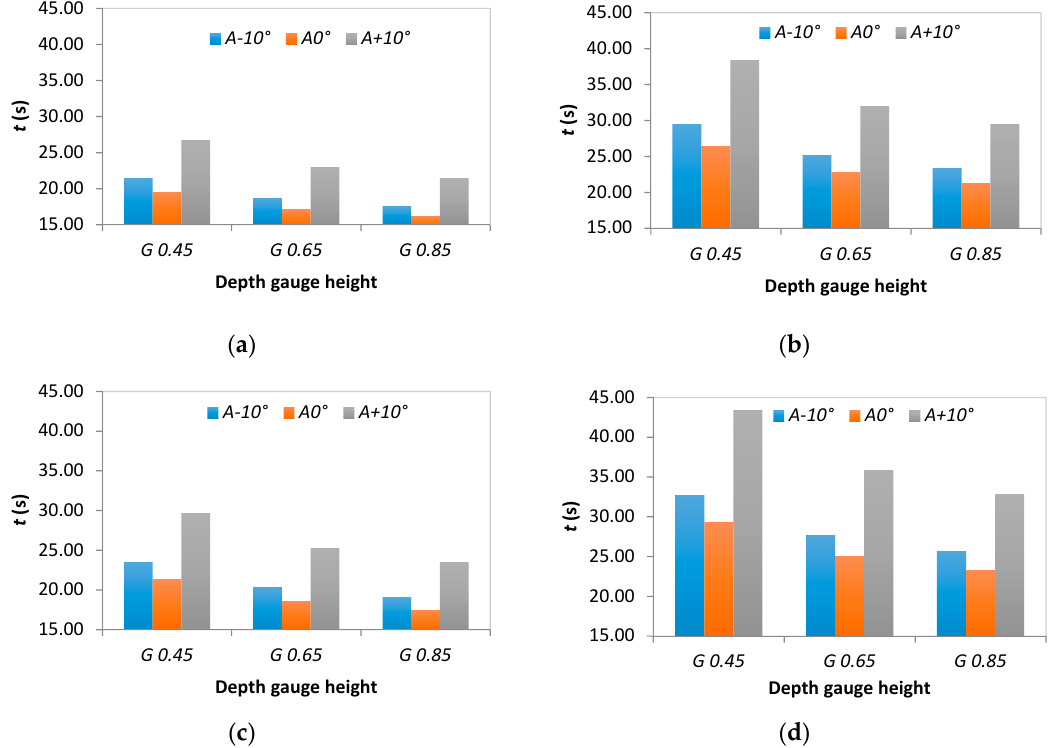
Figure 1. Dependency of cross cutting time ( t ) on depth gauge height ( G ) and top plate filing angle ( A ): ( a ) chain producer 1 and fir wood (minimum cross cutting time); ( b ) chain producer 1 and beech wood; ( c ) chain producer 2 and fir wood and ( d ) chain producer 2 and beech wood (maximum cross cutting time).